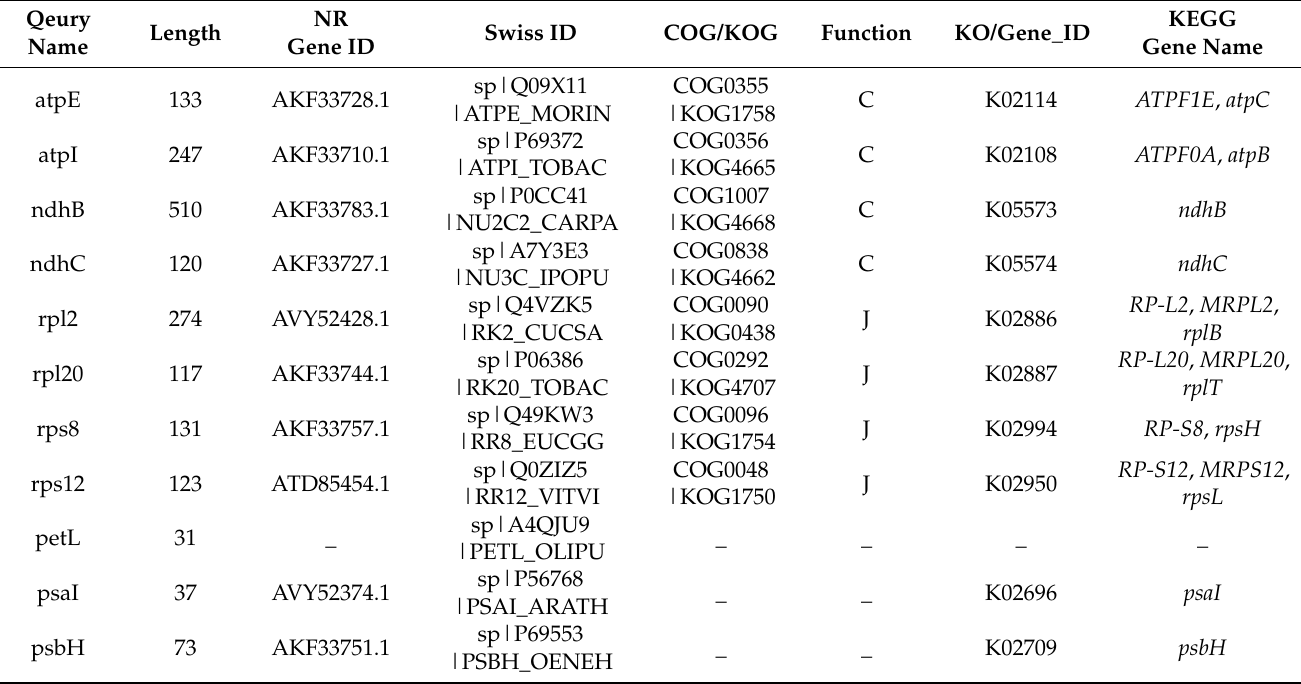
Table 8. Gene function annotation of 11 positive selection genes.